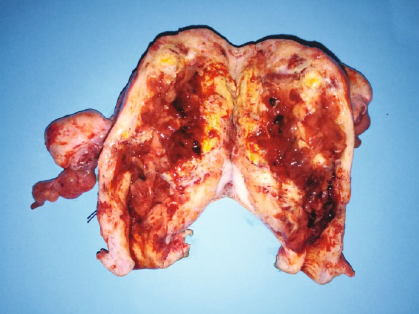
Figure 4: Specimen of the uterus and both adnexa measuring 12 × 8 × 6 cm. The cut sections show in fi ltrating ill-de fi ned multifocal tumor nodules, arising from the endometrium, measuring ~ 7 × 8 cm, gray-yellowish in color, soft fl eshy in consistency. The myometrium is thickened ~ 3-4cm, and the ovaries contain cystic